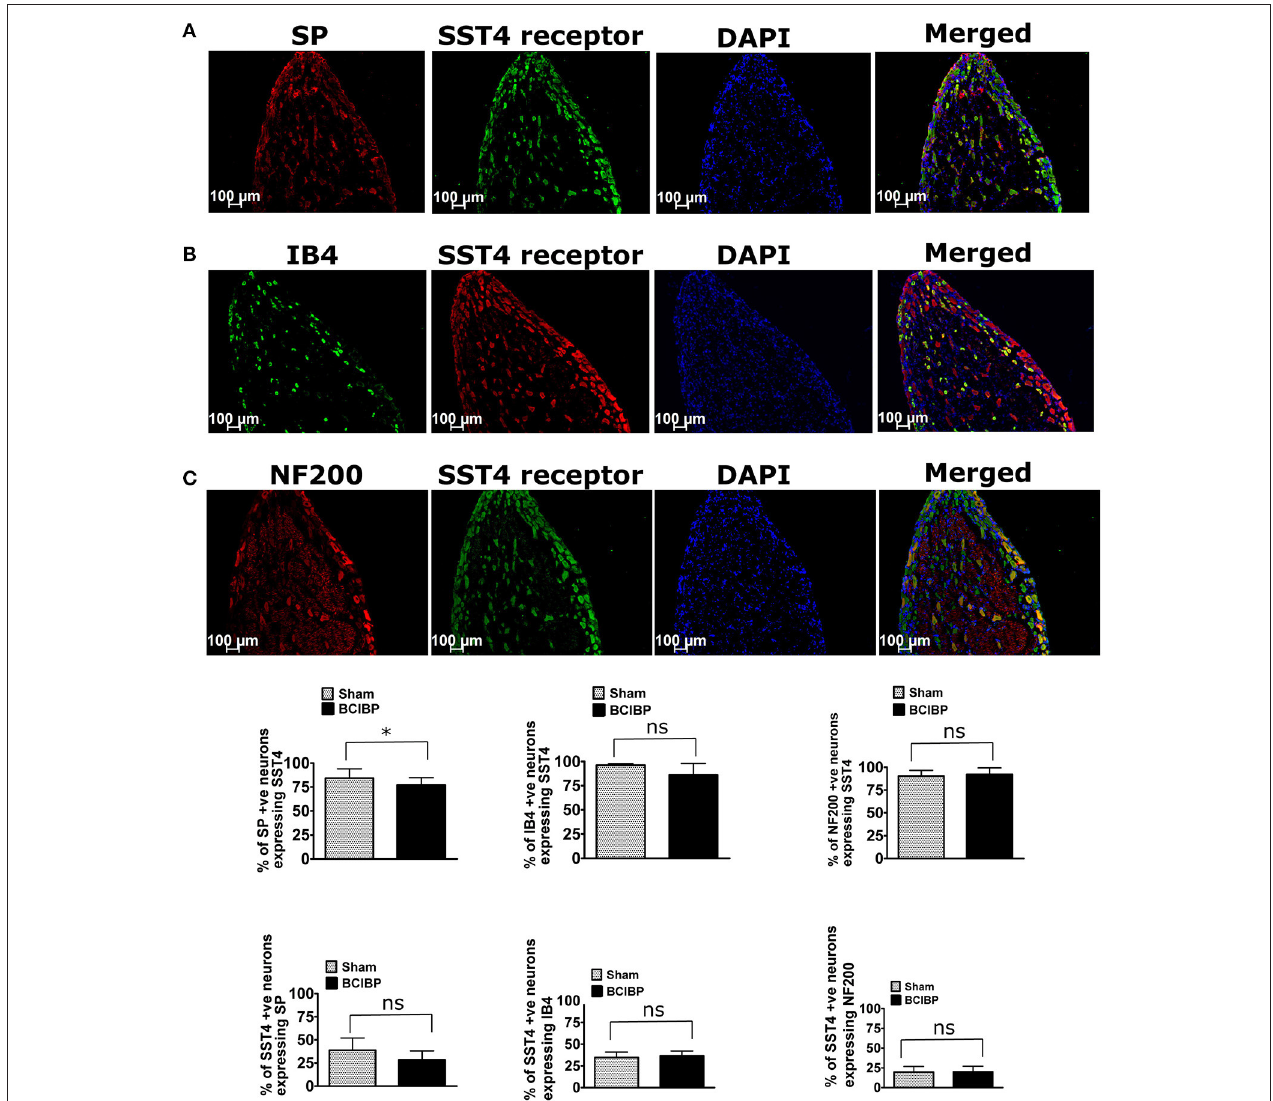
FIGURE 7 | Immunostaining showing co-localization of the SST4 receptor with (A) substance P (SP), (B) isolectin B4 (IB4), and (C) neurofilament 200 kDa (NF200) in representative sections from ipsilateral lumbar L4-L6 dorsal root ganglia (DRGs) of BCIBP-rats ( n = 3–4/group). ns, statistically not significant ( p > 0.05); * p ≤ 0.05 (Mann-Whitney